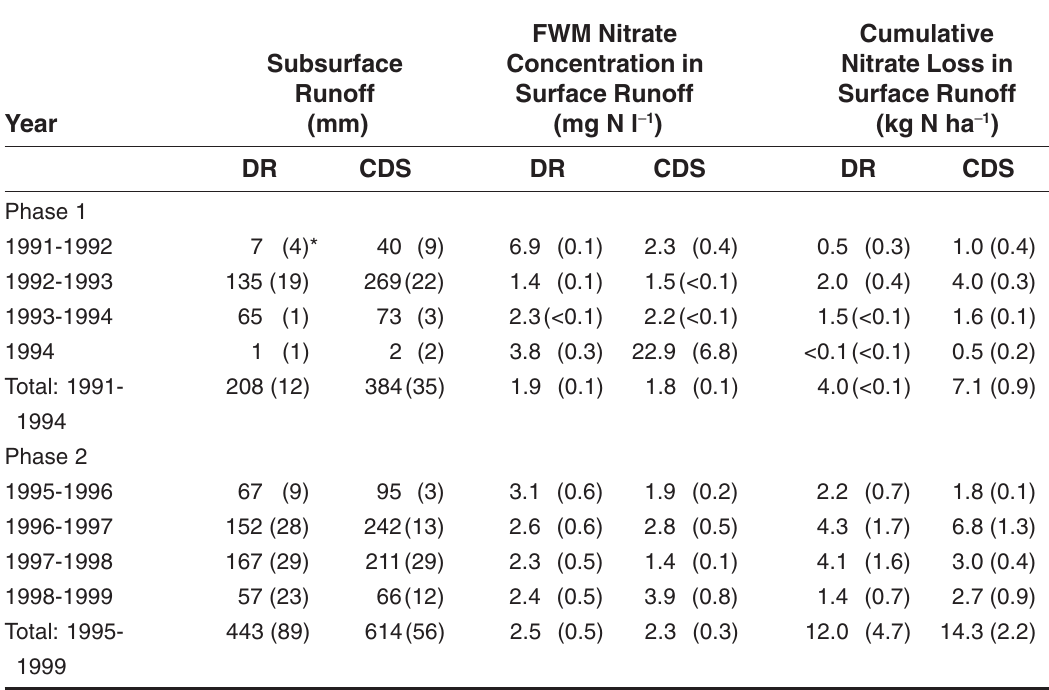
Surface Runoff, FWM Nitrate Concentrations and Cumulative Nitrate Loss in Surface Runoff for the DR and CDS Treatments during Phase 1 (Continuous Corn) and Phase 2 (Soybean-Corn